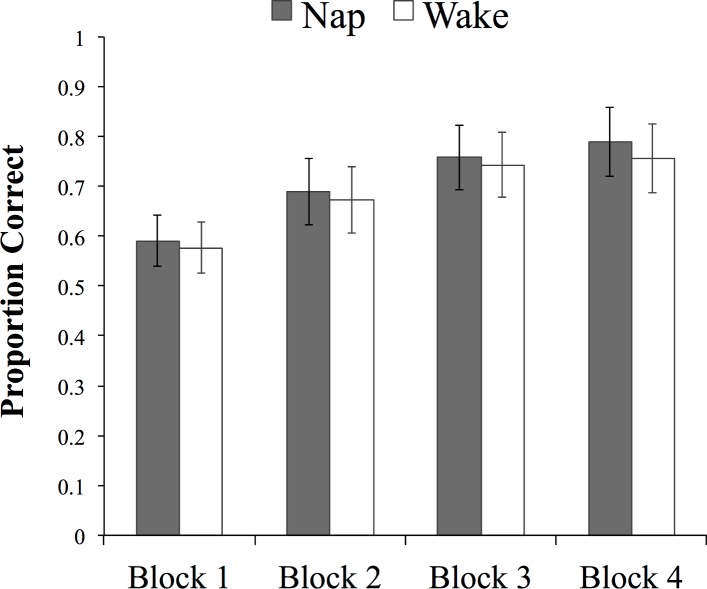
Accuracy (proportion of correct responses) during training in the two groups.Error bars represent 95% CIs.